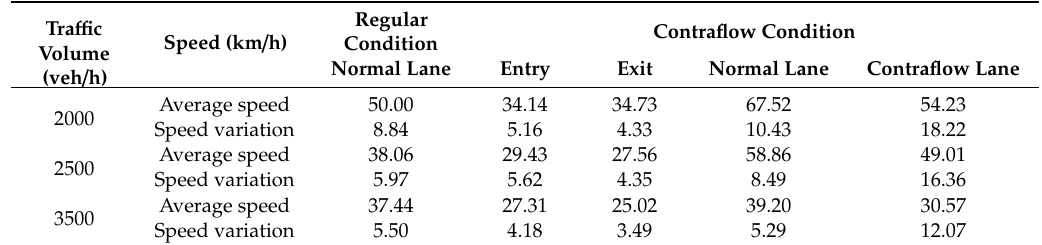
Table 1. Average speed and speed variation (km / h) on di ff erent lanes under regular and contraflow conditions. Tra ffi